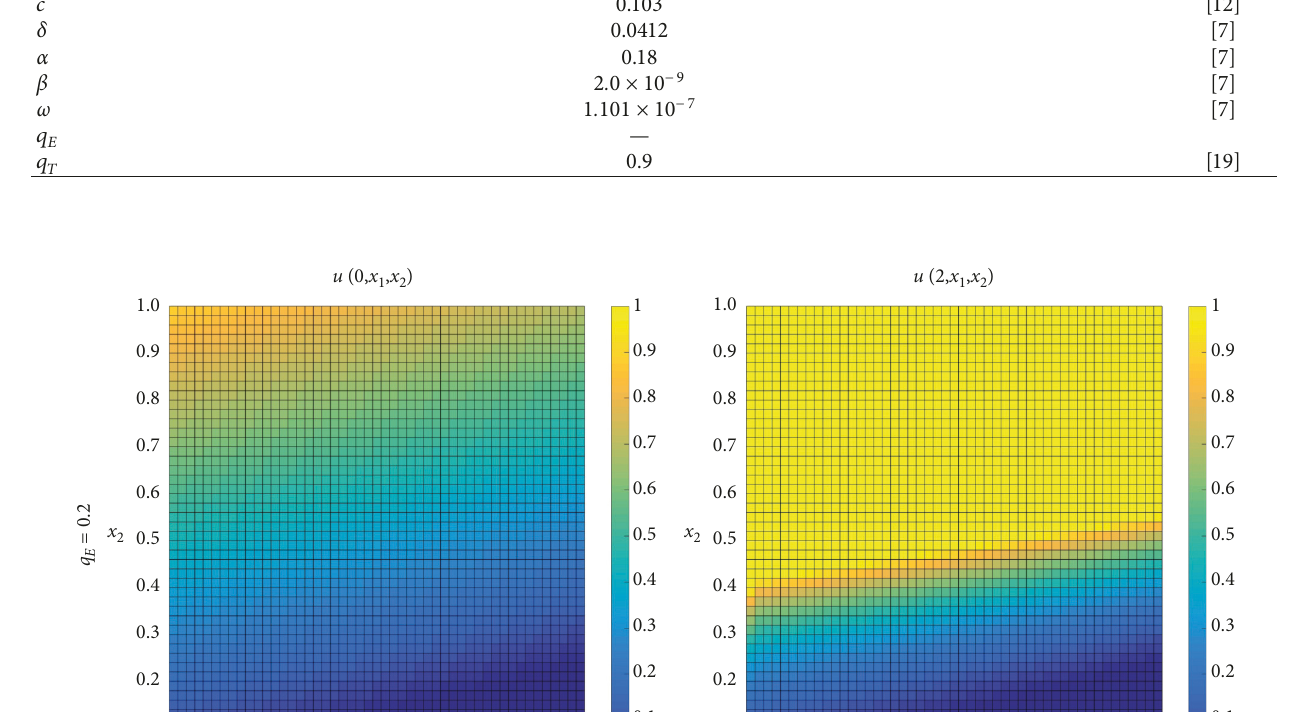
� 0 . 2 (upper panels) and with q E